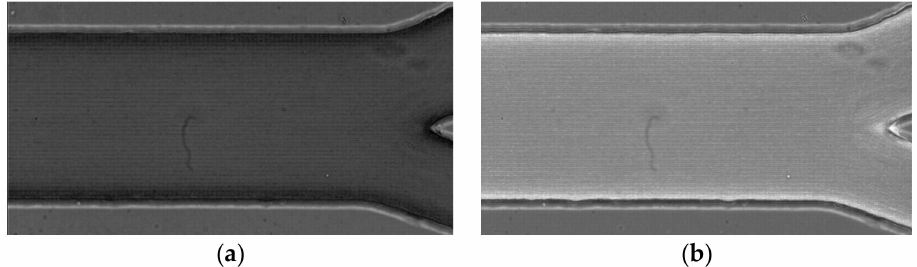
Figure 12. ( a ) The obtained image with the projection minimum intensity, and ( b ) the obtained image with the projection maximum intensity.